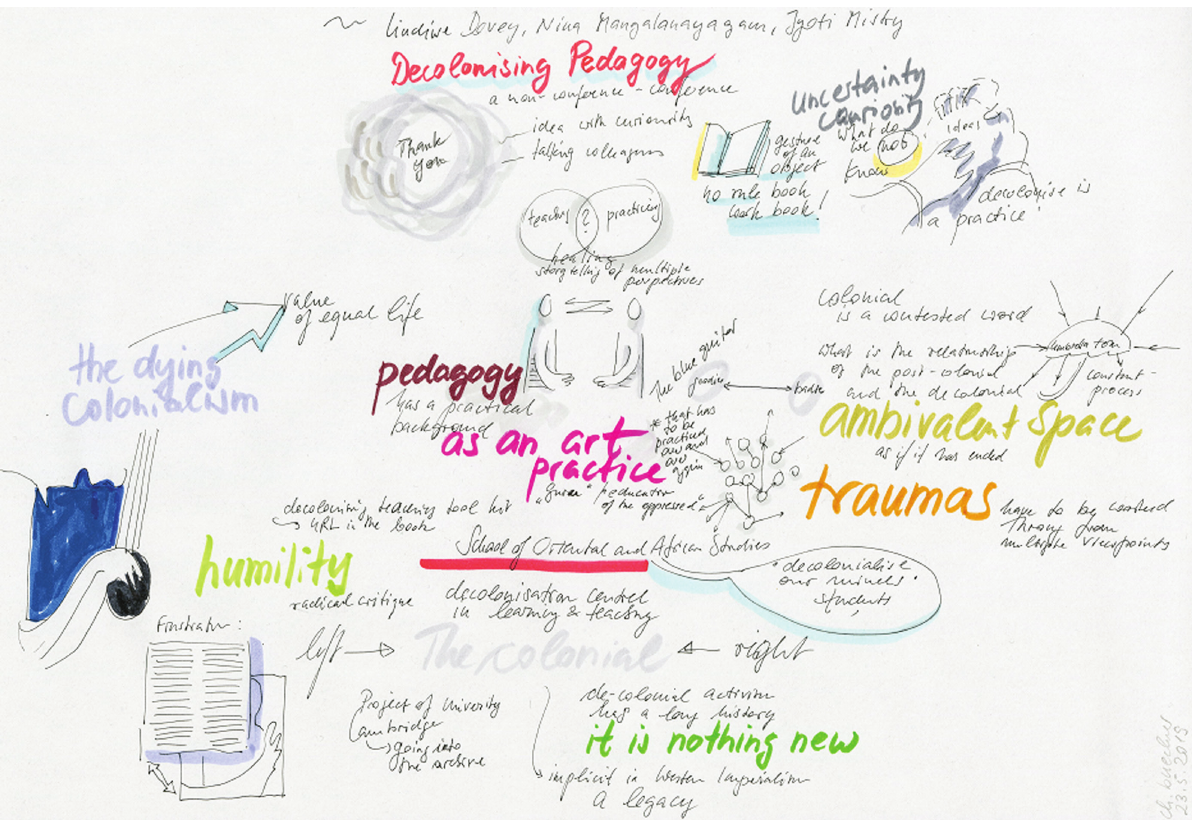
Figure 2. Summative drawing by Christiane Büchner from introduction session with Lindiwe Dovey, Nina Mangalanayagam and Jyoti Mistry (Source: Jyoti